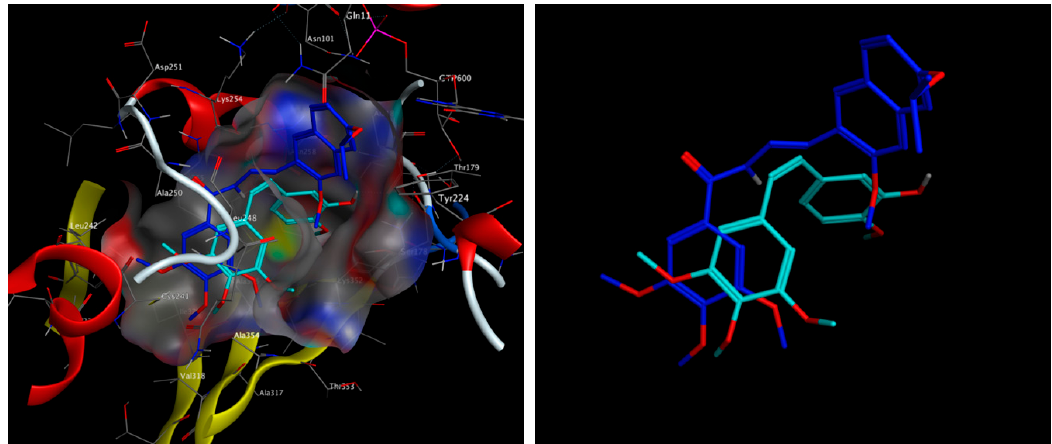
Figure 7. Quinoline 19h (blue) and CA-4 (cyan/light blue) docked at the colchicine-binding site of tubulin in co-crystal 1SAO. Protein residues removed on right for clarity. (red = oxygen, grey = hydrogen).